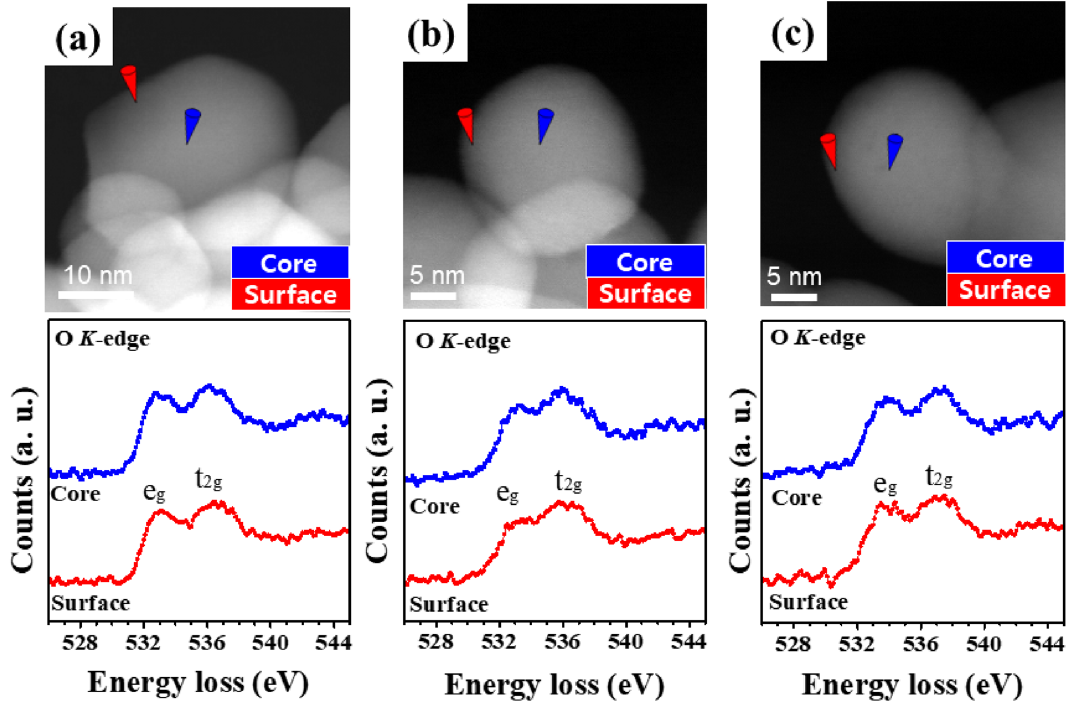
Figure 4. ( a – c ) STEM–EELS images and O K -edge ELNES spectra of ( a ) ZrO 2 , ( b ) ZrO 2 -B, and ( c ) Cr@ZrO 2 NPs. Red and blue cones indicate the probing sites at the surface and the core of each NP,